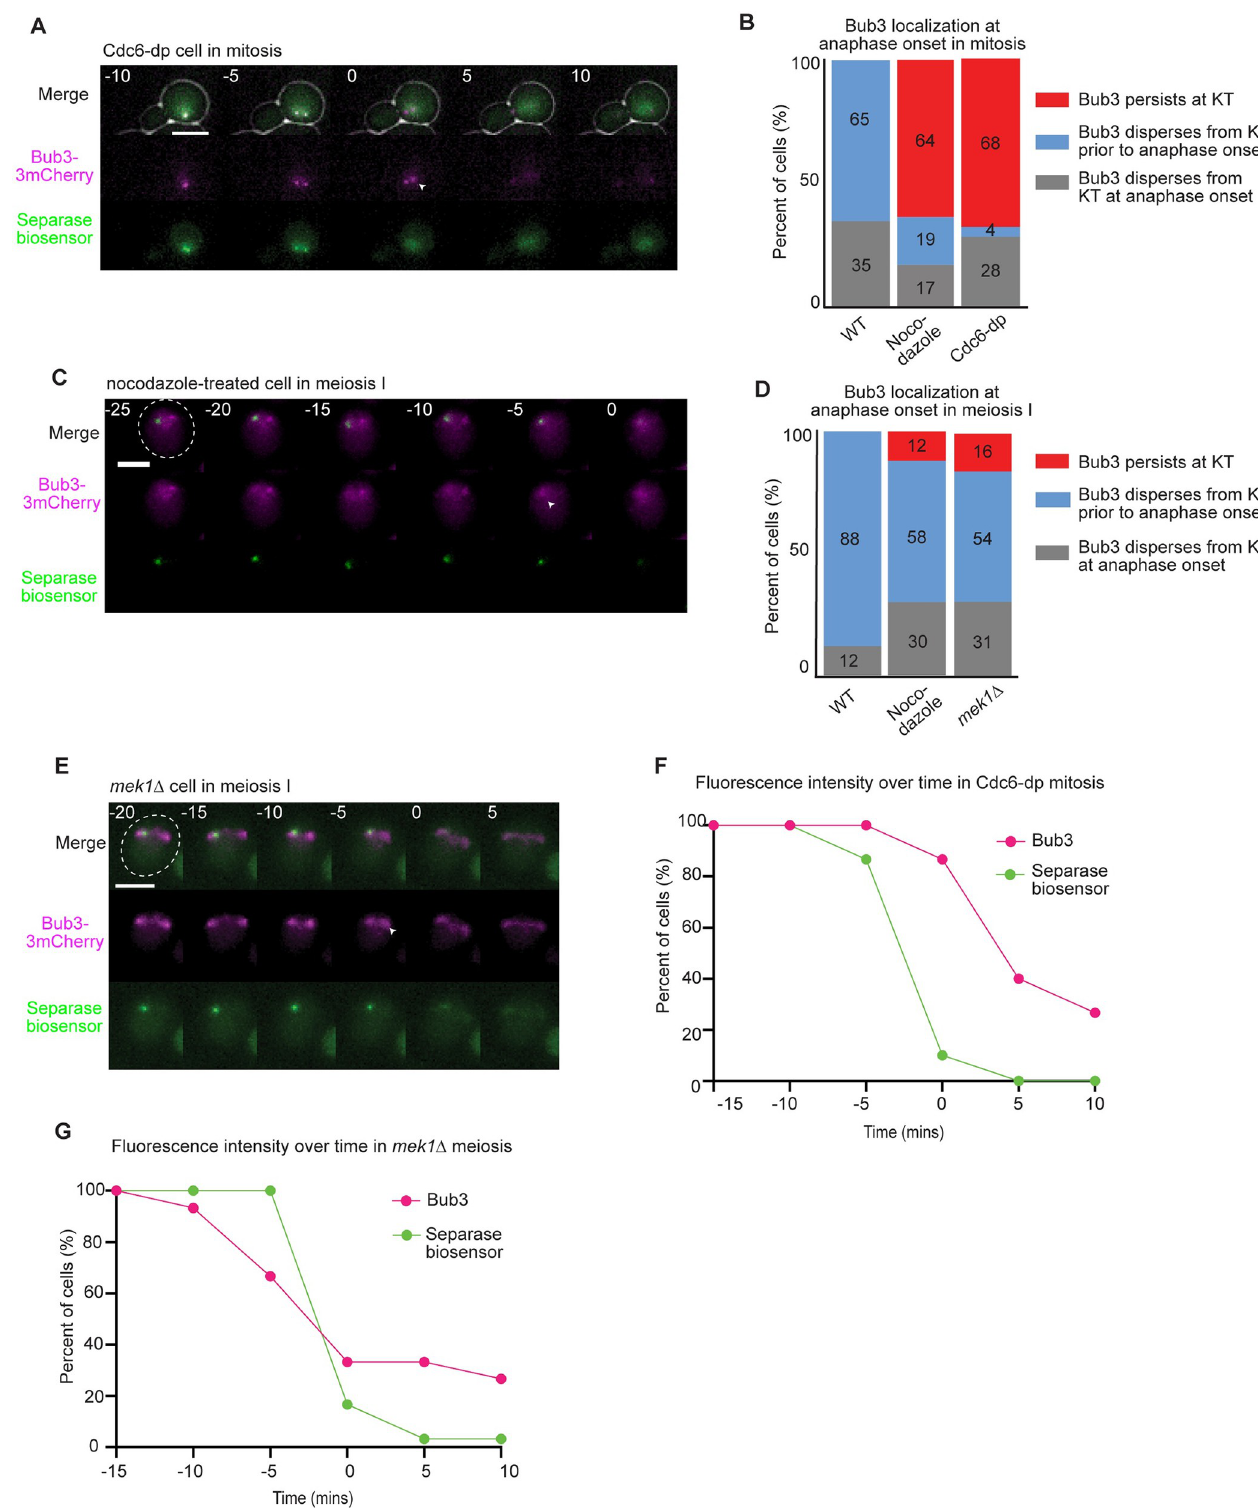
Fig 4. The spindle checkpoint is inappropriately silenced in meiosis I but not in mitosis. A) Representative time-lapse images show cells entering anaphase, as indicated by the dispersal of separase biosensor focus. Time 0 indicates anaphase onset. Scale bars = 5 μ m. Arrowhead shows Bub3-3mcherry focus after anaphase onset. B) Quantification of Bub3-3mCherry localization at anaphase onset in mitosis. n � 50 cells per genotype. C) Representative time-lapse images of